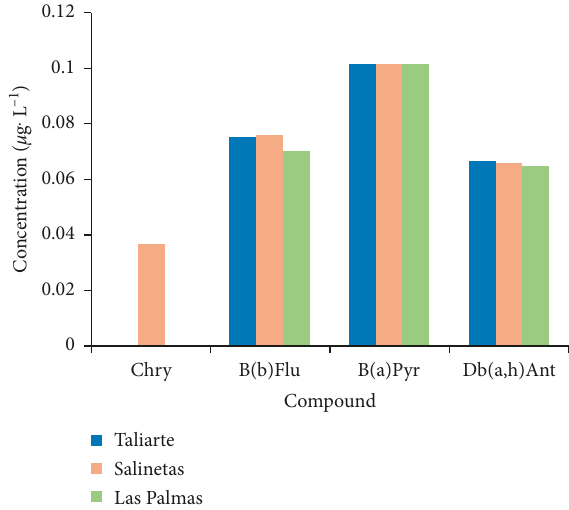
Figure 5: Results of applying the method to real, uncontaminated samples at different points of Gran Canaria, Canary Islands, Spain.